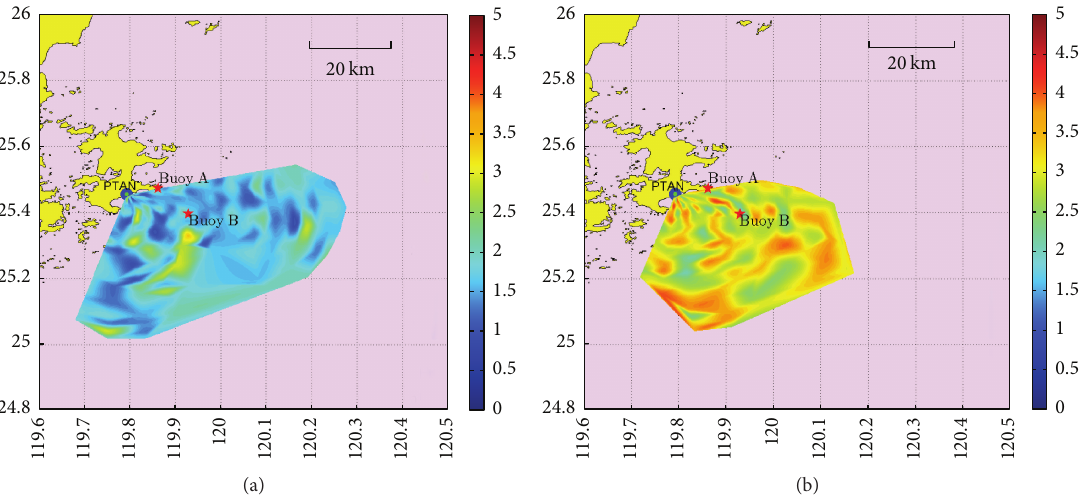
Figure 7: The wave maps after interpolating in two-dimensional space. (a) 21:00 to 23:00 Sep 27, 2014; (b) 17:30 to 19:30 Oct 9, 2014.